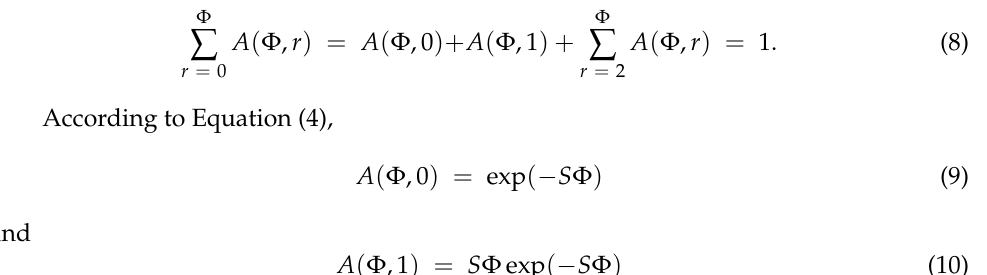
Figure 3. Fraction of amorphized area as a function of Xe ion fluence. Green circles, blue line, and red line represent the experimental result [21], result calculated by Equation (7) and the result from two-dimensional images,